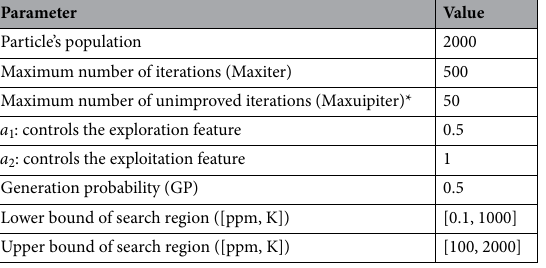
Table 1. Parameters of EO. *Item added to the original algorithm to improve computational efficiency.